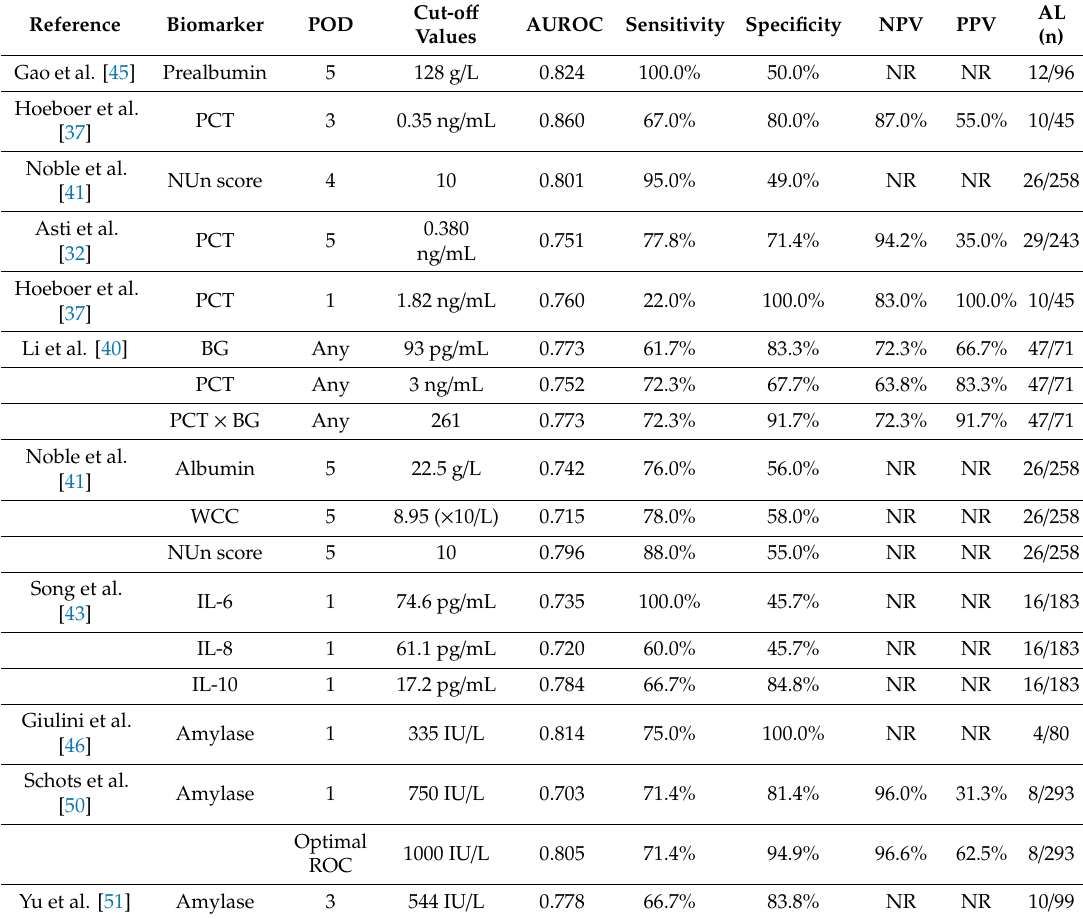
Table 4. Summary of other (very) good biomarkers (AUROCs >